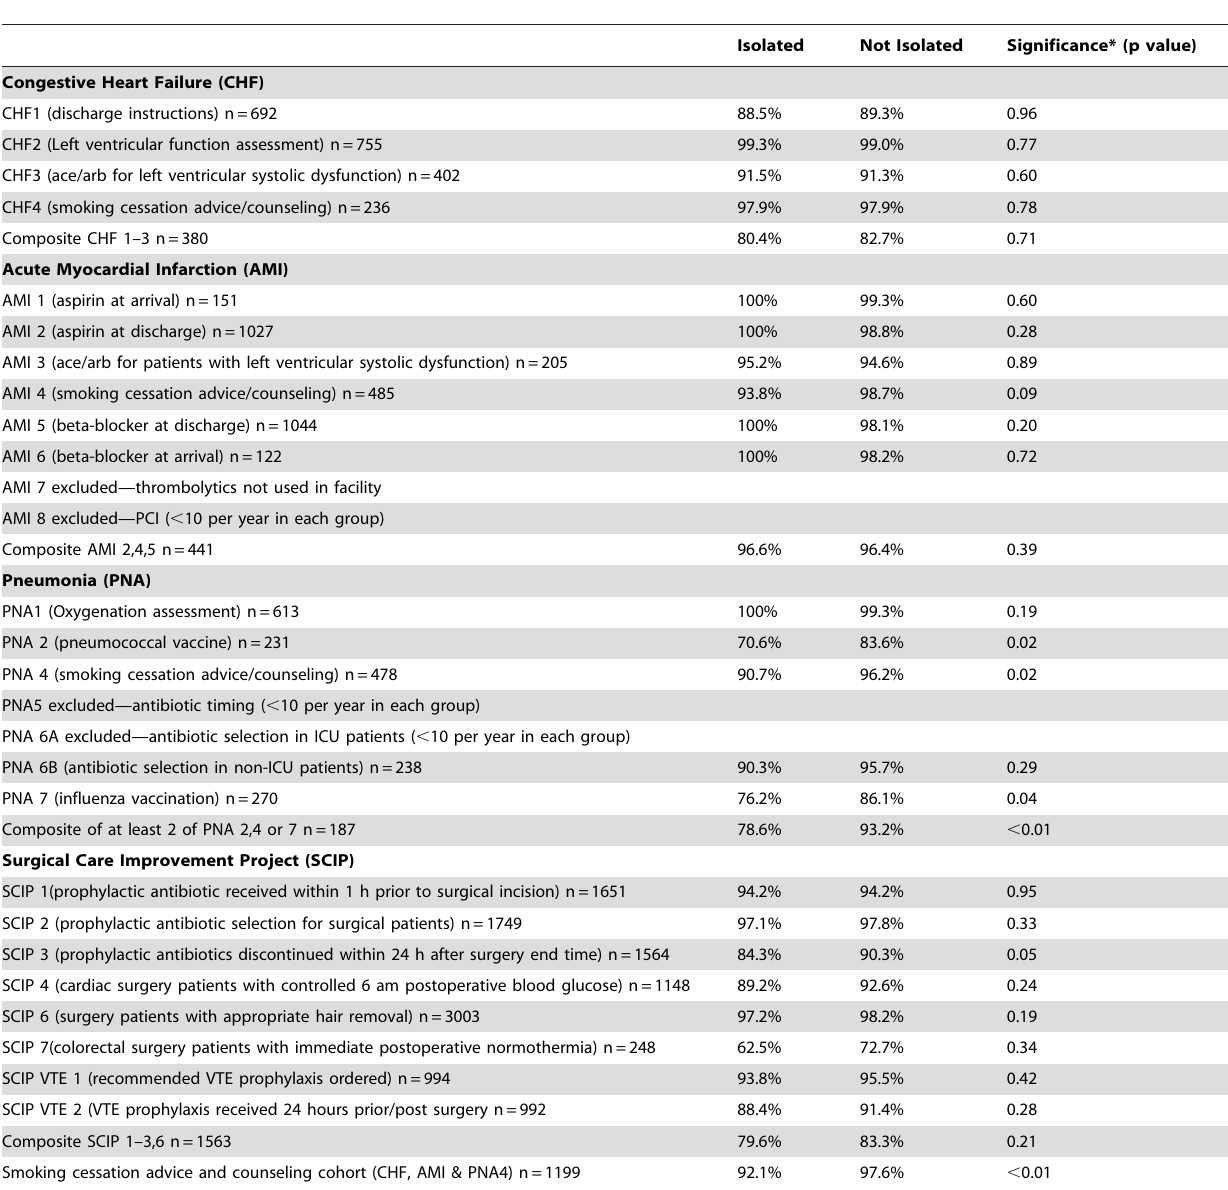
Table 4. Secondary analysis of individual process measures presented as proportion of isolated and un-isolated patients successful on each